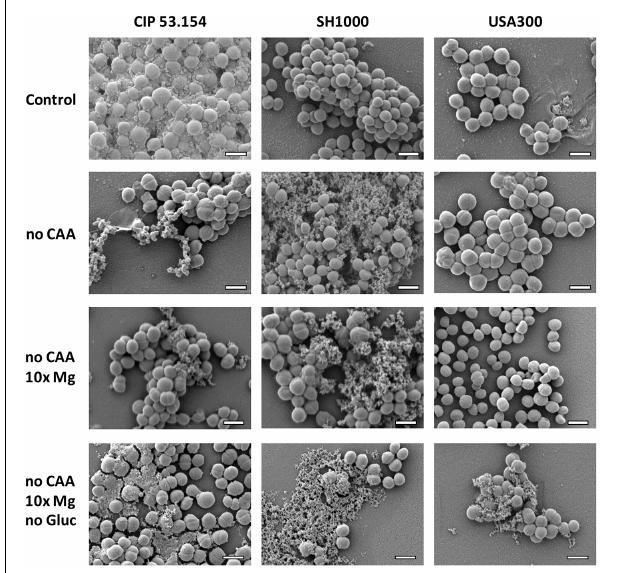
FIGURE 5 | Impact of starvation, magnesium excess, and hypoxia on S. aureus biofilm matrix. Biofilms were grown in minimal medium (control) or modified minimal medium (no CAA, without casamino acids; 10 × Mg, 10 × minimal medium concentration; no Gluc, without glucose) without oxygen for 24 h before imaging. Representative images of scanning electronic microscopy acquisitions at 15,000 × are shown. The scale bar indicates 1 µ